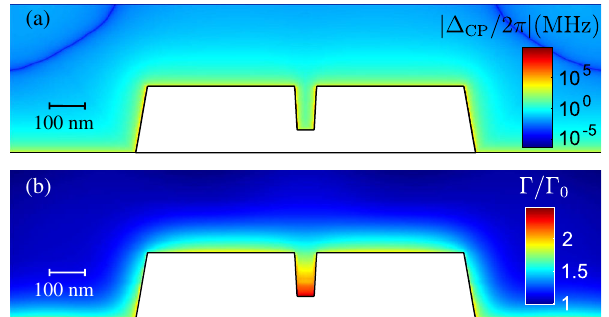
FIG. 5. Casimir-Polder line shift (a) and modified decay rate (b) plotted in the cross section of a waveguide with w d ¼ 75 nm. Note that, in (a), the color scale corresponds to the logarithm of the absolute value of the shift. In the vicinity of the surface, the transition frequency is redshifted. However, at larger distances, a positive resonant potential contribution cancels (dark blue region) and overcomes the negative off-resonant potential such that the total shift becomes positive and the line is blueshifted. Further, the total decay rate Γ of the 5 2 P 3 = 2 state (b) approaches its vacuum value of Γ 0 at large